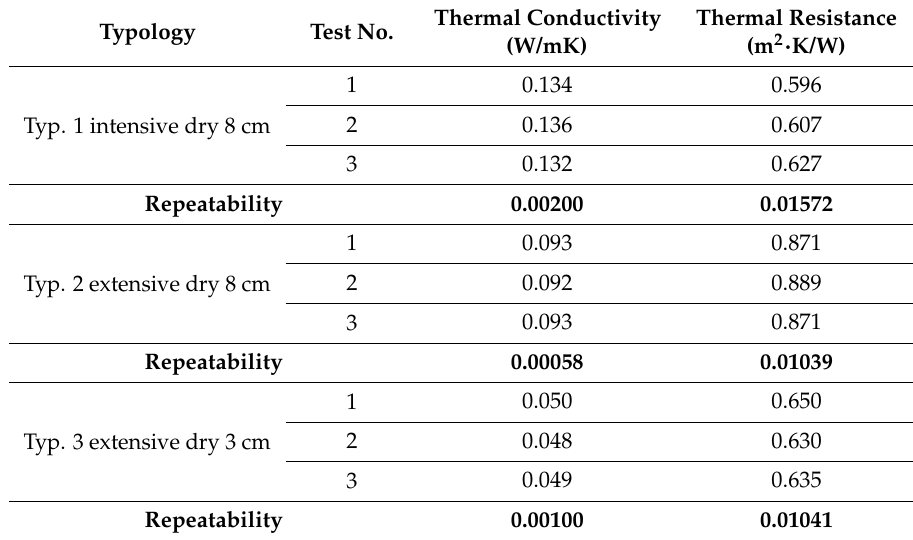
Figure 7. Comparison between heat flow meter validation results. Table 11. Comparison between heat flow meter results.